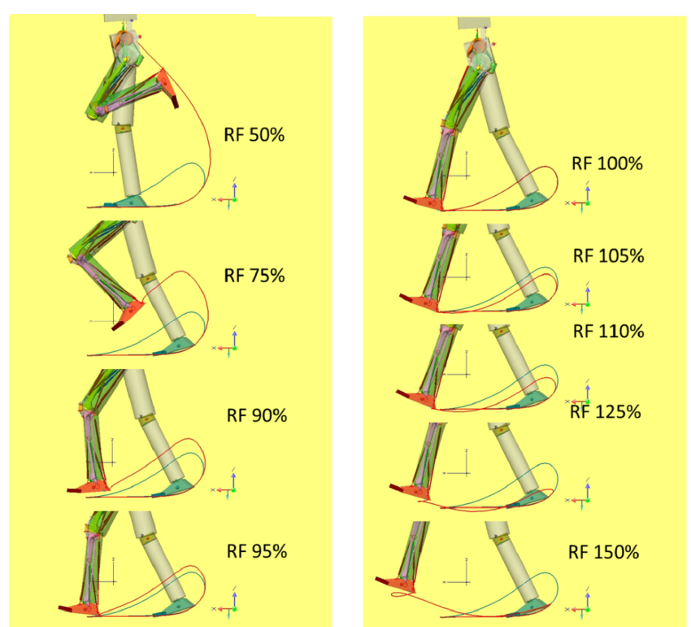
Figure 5. Left: kinematics resulting from decreasing RF force; right panel: kinematics resulting from increasing RF force. The model is represented in the position achieved at the end of stride time (100% stride time). The red and blue curves represent the trajectory of a point located on the heel of, respectively, the right side (unaffected, blue line) and the left side (our test limb, red line). The hip joint flexion was not imposed (no compensation for RF force changes).